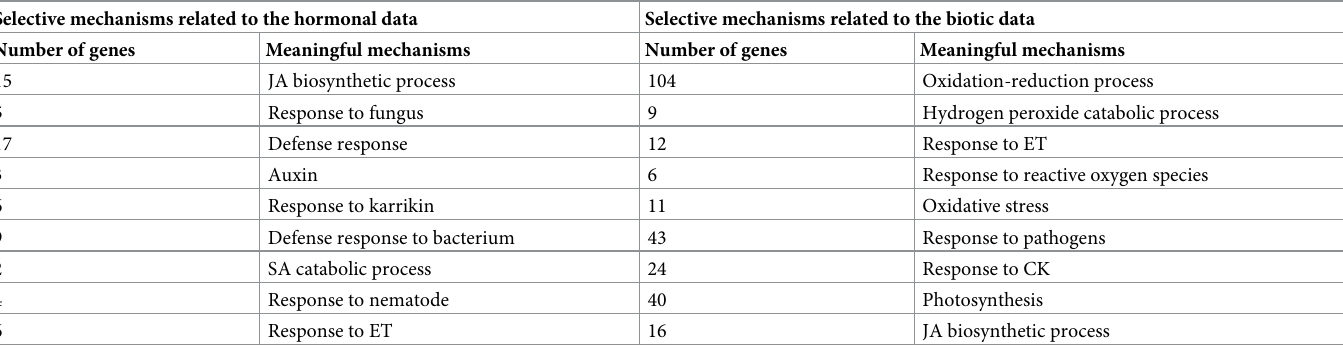
Table 7. The most important molecular mechanisms related to the biotic and hormonal studies. Selective mechanisms related to the hormonal data Selective mechanisms related to the biotic data Number of